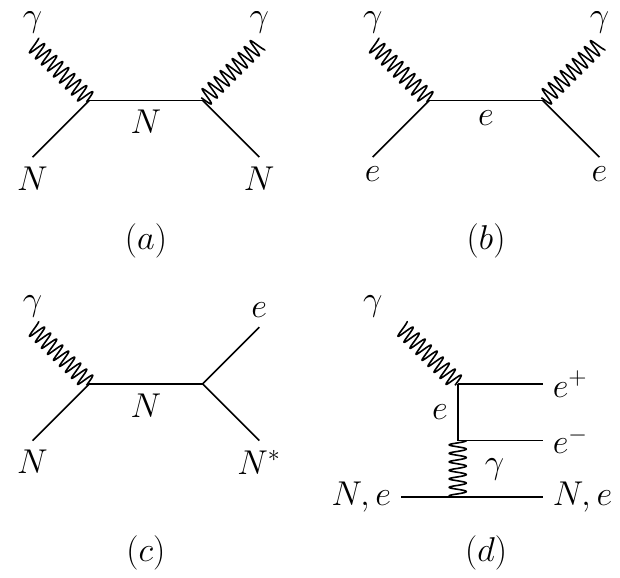
Figure 1 . SM photon scattering processes. Process ( a ) corresponds to elastic scattering (Rayleigh), process ( b ) to inelastic scattering (Compton), process ( c ) to photo-electric absorption and process ( d ) to electron-pair production in the field of the nucleus or electron. Photons produced at the nuclear reactor core can undergo any of these processes when interacting with the reactor